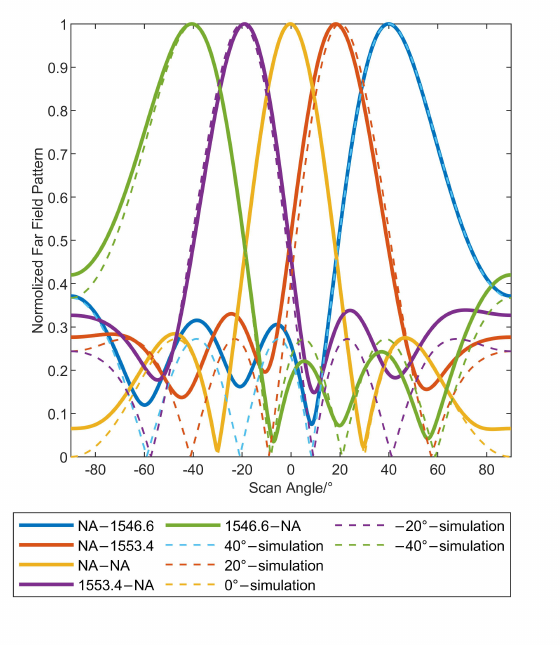
Figure 10. Far-field pattern of wide-angle